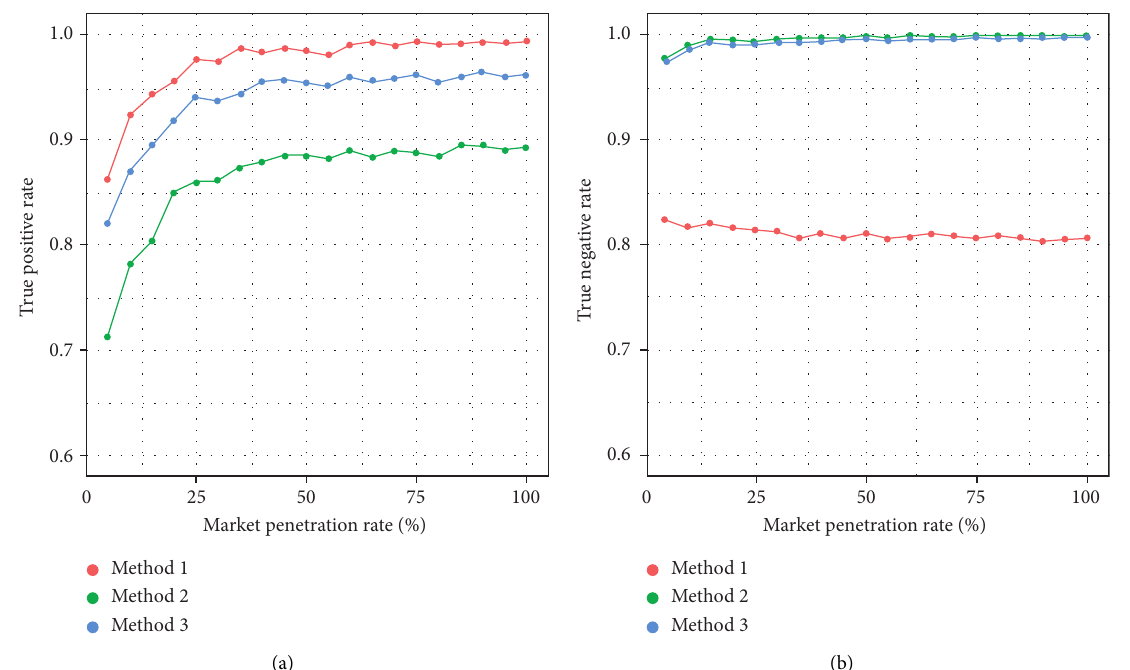
Figure 7: Results of the three classification methods. (a) TP rates at different MPRs. (b) TN rates at different